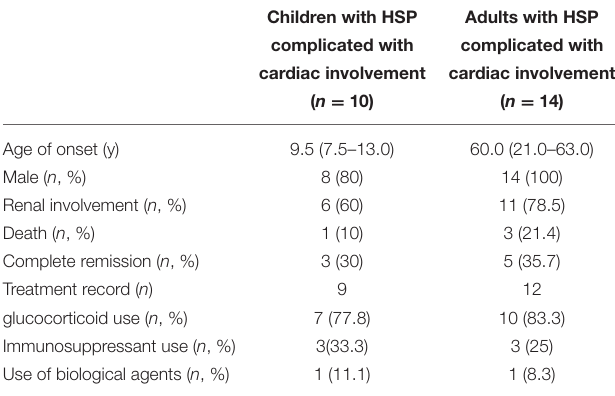
TABLE 3 | Comparison of reported pediatric and adult HSP/IgAV patients with cardiac